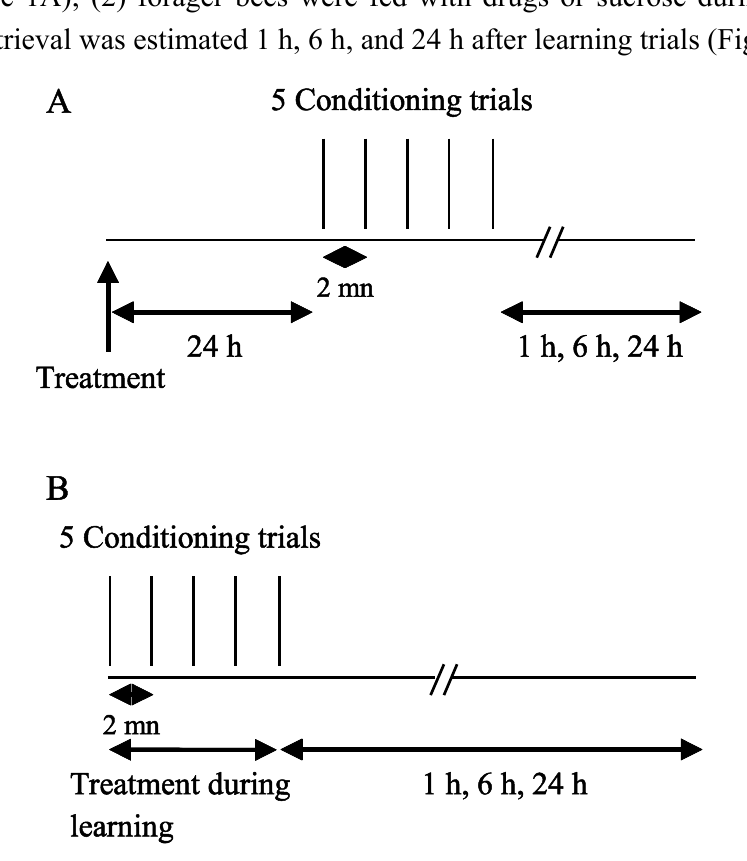
Figure 1. Behavioral paradigm used to evaluate the effects of ACT and DEL on learning and retrieval in the forager bees. ( A ) Drugs were orally applied 24 h before learning sessions; ( B ) bees were fed with drugs during learning sessions and then the retrieval was evaluated at 1 h, 6 h, and 24 h after learning